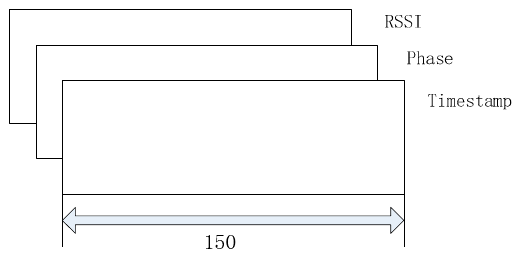
Figure 4. Convolutional layer input data.